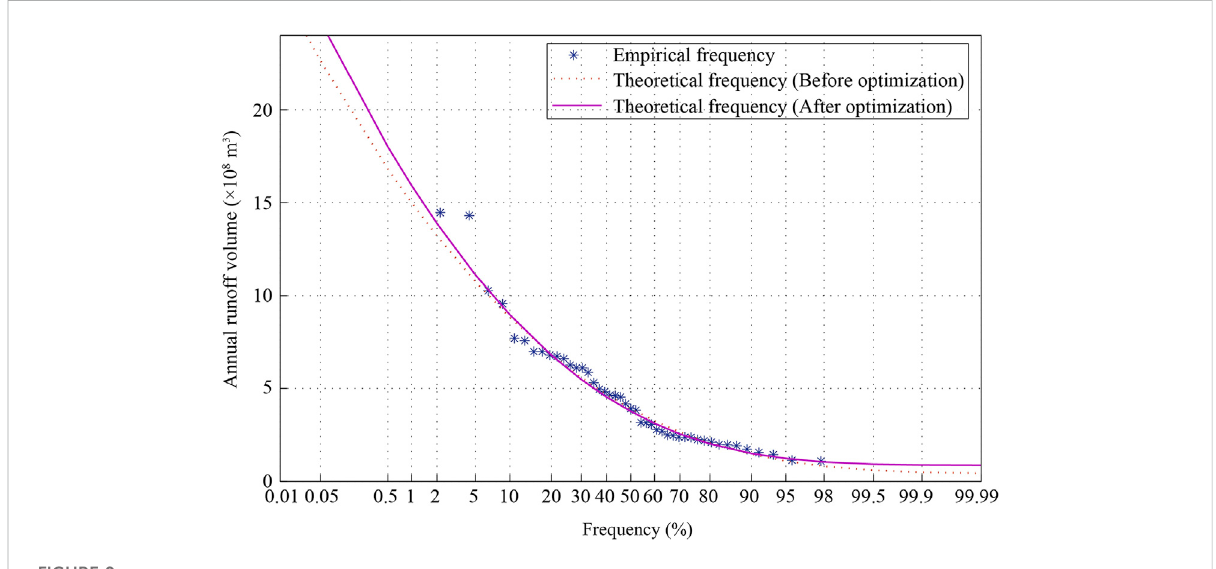
FIGURE 9 Annual runoff frequency curve of Xidayang